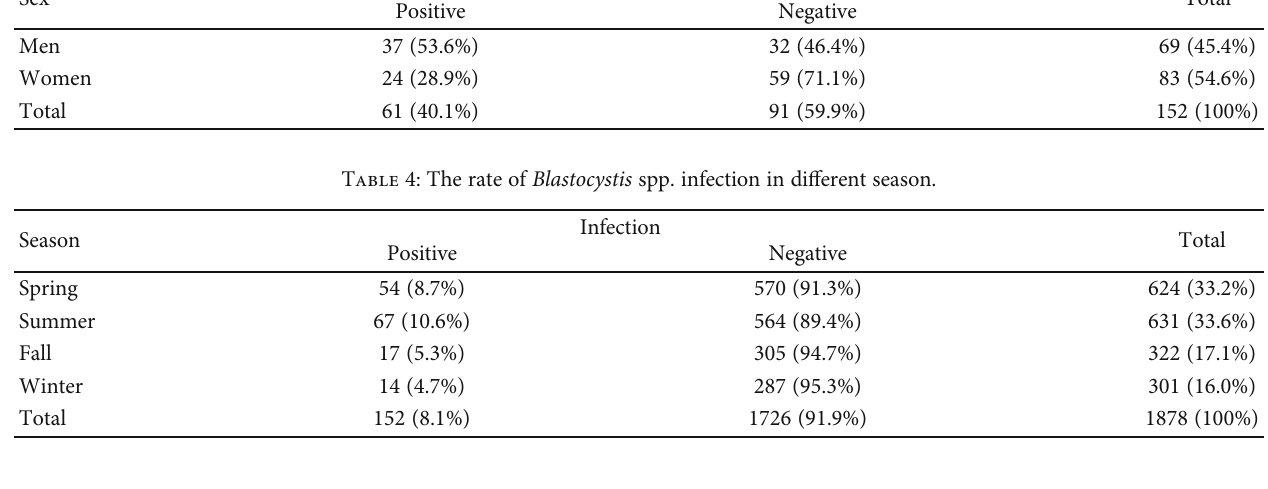
Table 5: The percentage of other parasites in the patients.